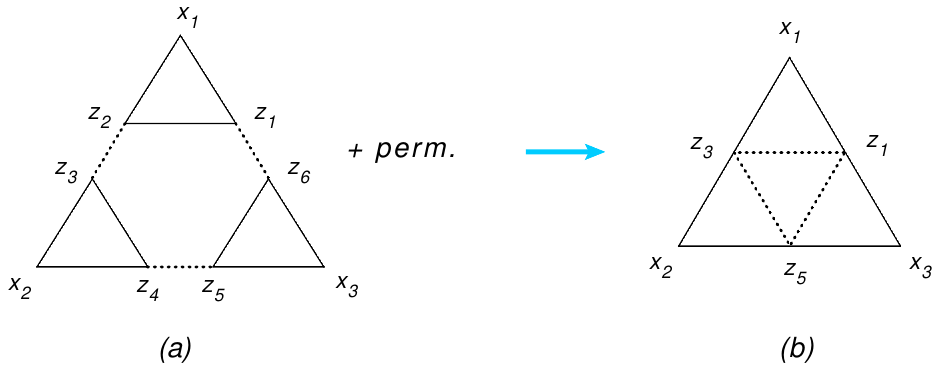
Figure 11 . Transverse integral. Solid lines denote usual \propagators" of the type ( z i (cid:0) z j ) 2 (cid:21) and dotted lines expressions of the type [( z i (cid:0) z j ) 2